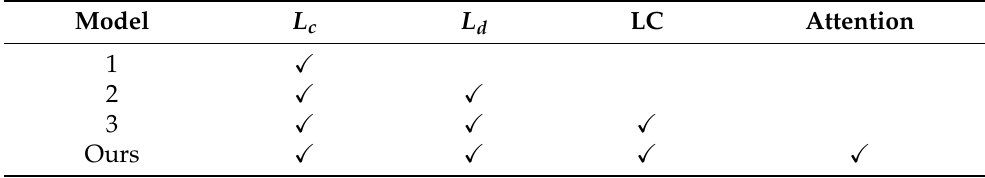
Table 1. Comparison of different